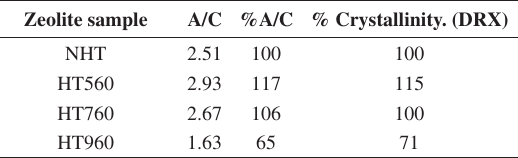
Table 4. Relative crystallinity of zeolite samples NHT, HT560, HT760 and HT960. Calculated from the absorbance ratio (A/C) of bands at 550 cm –1 (A) and 800 cm –1 (C) and from XRD peak height at a diffraction angle 2 θ of 24.3°. Zeolite